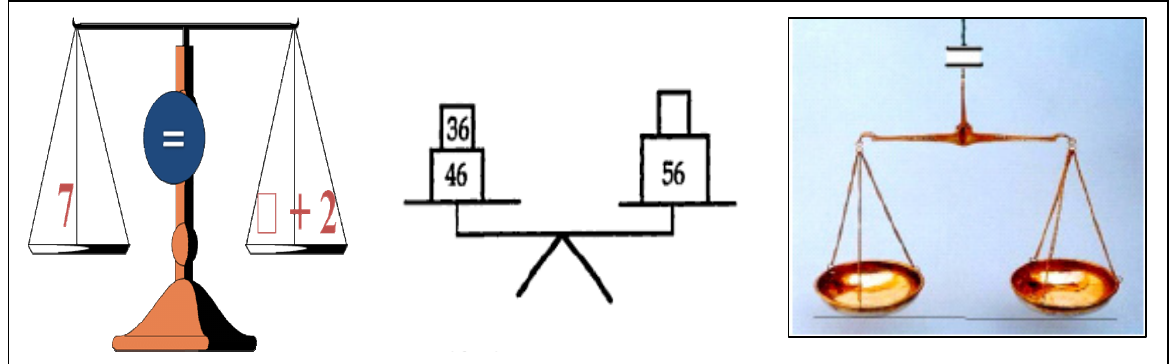
Figure 5 : Different scaling systems which can be used to introduce the equal